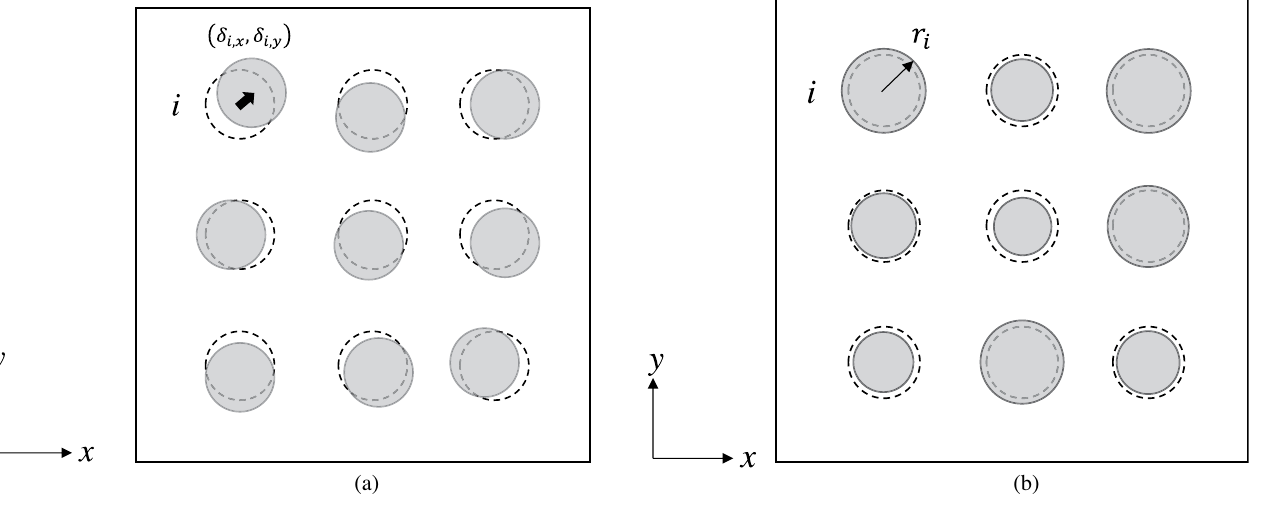
Fig. 2. Disordered 2DMPC formed by supercell method: (a) positional disorder and (b) size